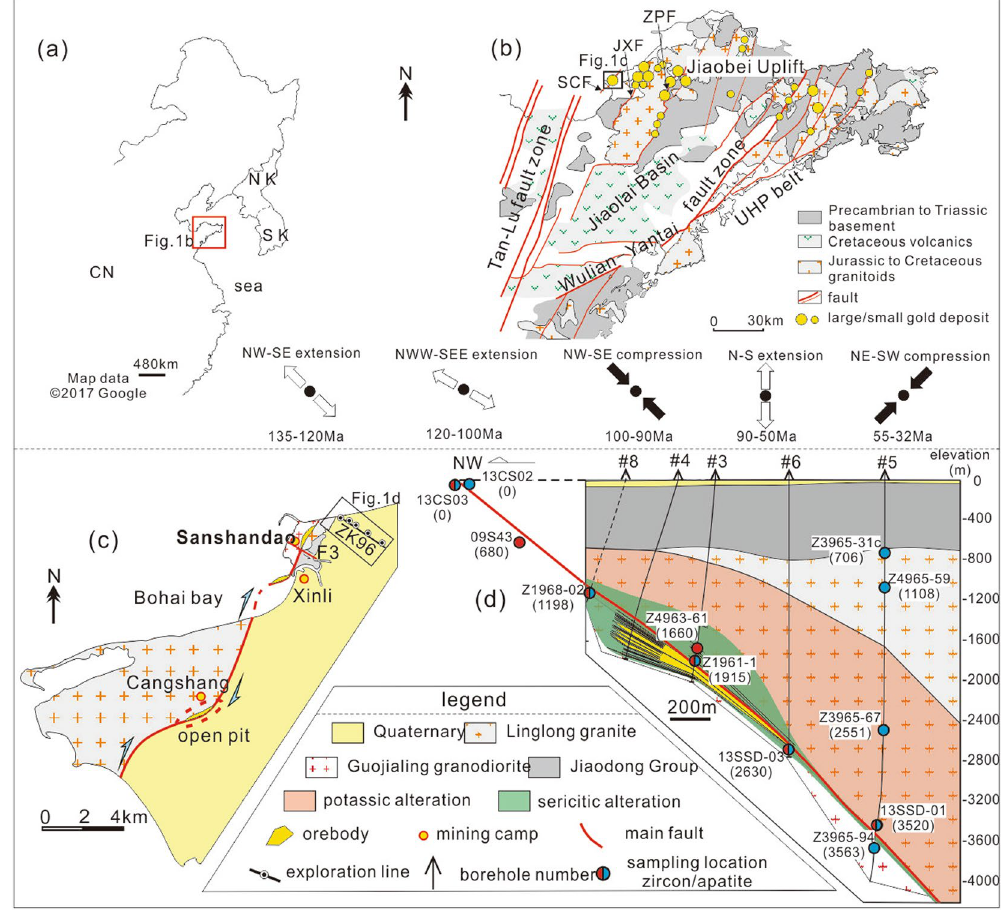
Figure 1. Maps showing the location ( a ) and general geology ( b ) of Jiaodong; Geologic maps showing the Sanshandao-Cangshang belt ( c ) and sampling localities ( d ); CN: China, NK: North Korea, SK: South Korea, SCF: Sanshandao-Cangshang fault, JXF: Jiaojia-Xincheng fault, ZPF: Zhaoyuan-Pingdu fault, UHP: ultra-high pressure; the paleostress directions in Fig. 1b are from ref. 20. Note samples 13CS02 and 13CS03 were collected from the Cangshang open pit, and 09S43 was collected from underground tunnel at Sanshandao. Numbers in the parentheses after the sample number represent sampling depth. Figure 1a was made with data from Google Maps (https://www.google.com/maps), and was reproduced using CorelDRAW × 6 (http://www.coreldraw. com/en/). Figure 1b,c,d were adapted from ref.